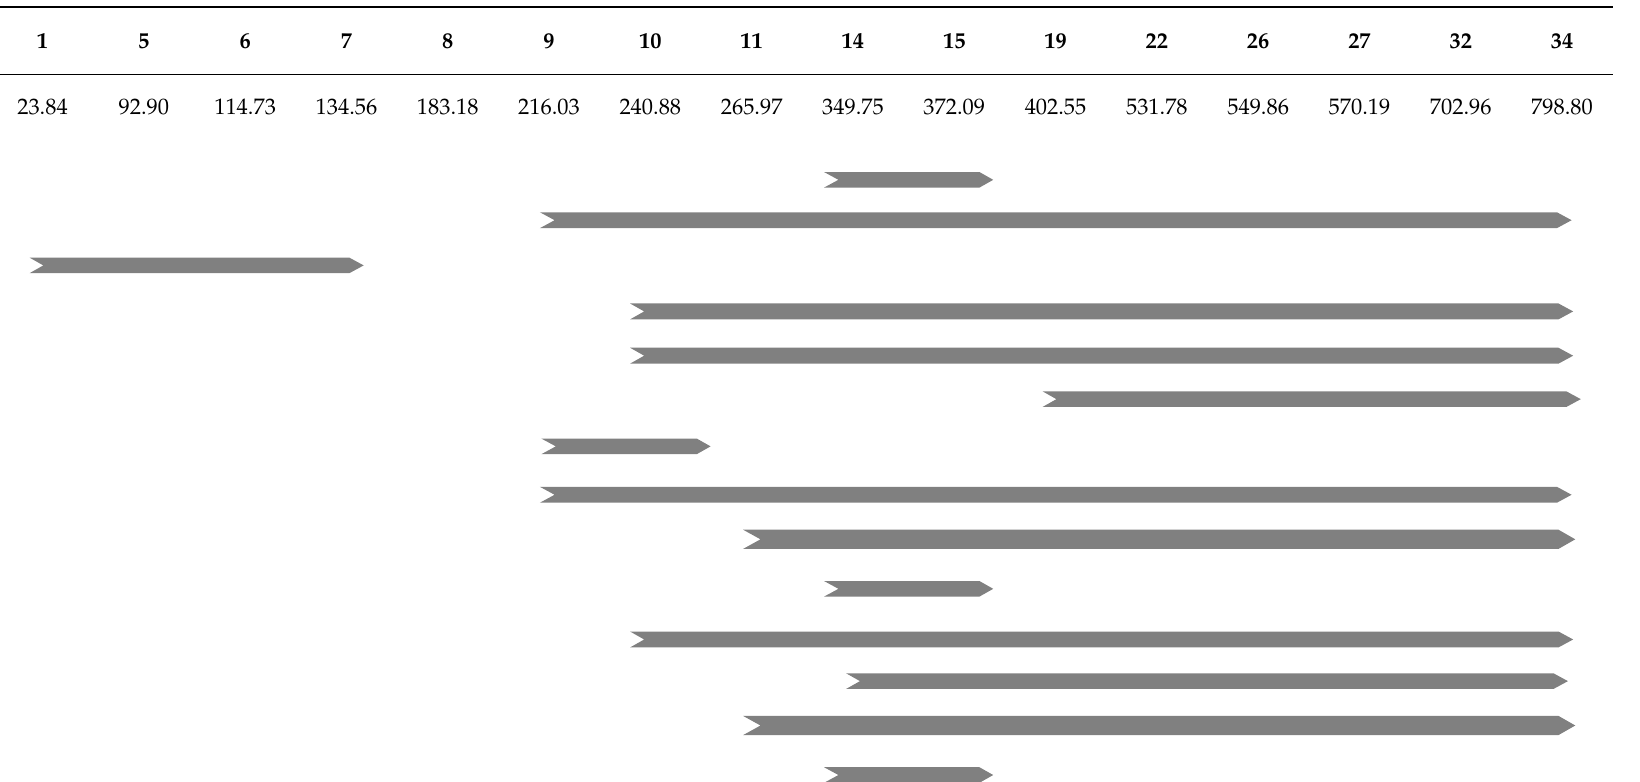
Table 2. Mutations found only during specific time intervals.